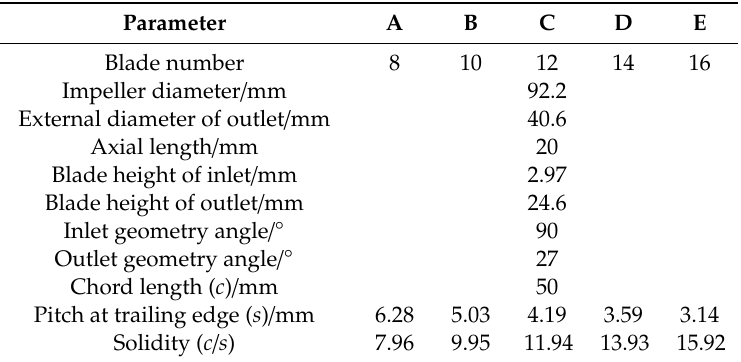
Table 1. Geometric parameters of the impeller.